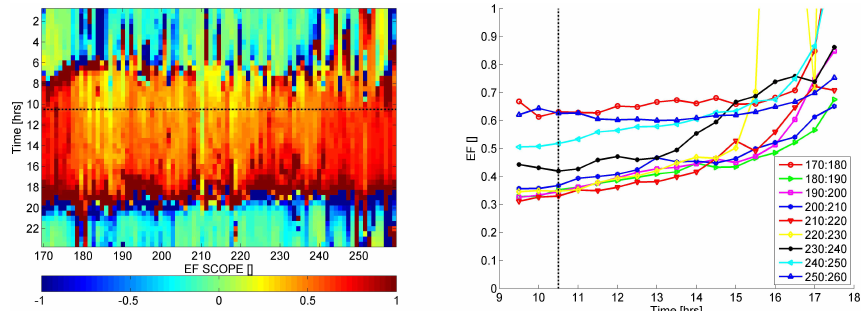
Fig. 7. Diurnal variation of the evaporative fraction during the maize growing season. In the left panel the diurnal evaporative fraction as calculated by the SCOPE model for each day is shown. In the right panel the 10 day average of the diurnal evaporative fraction as calculated with SCOPE is shown. The dotted line represents the overpass time of